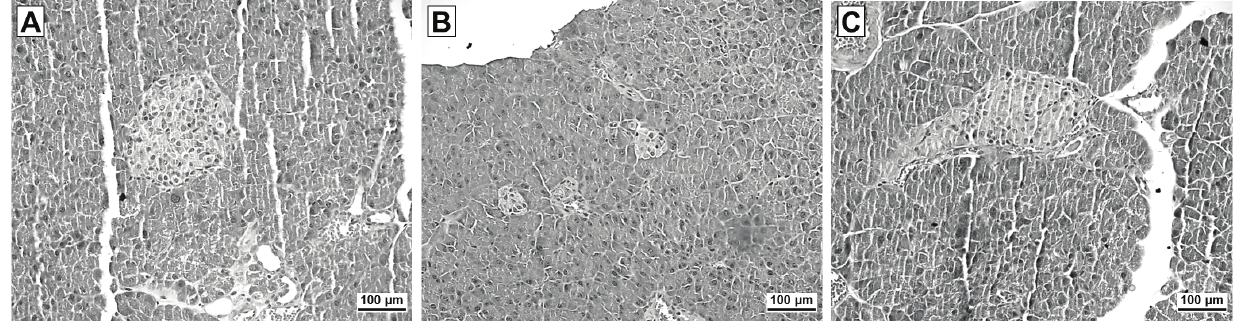
FIGURE 3 - Histology of pancreatic tissues stained by hematoxylin and eosin (HE) from Control group (A), Diabetes Mellitus group (B) and diabetic Cissampelos sympodialis treatment group (C). Magnification 100 X.